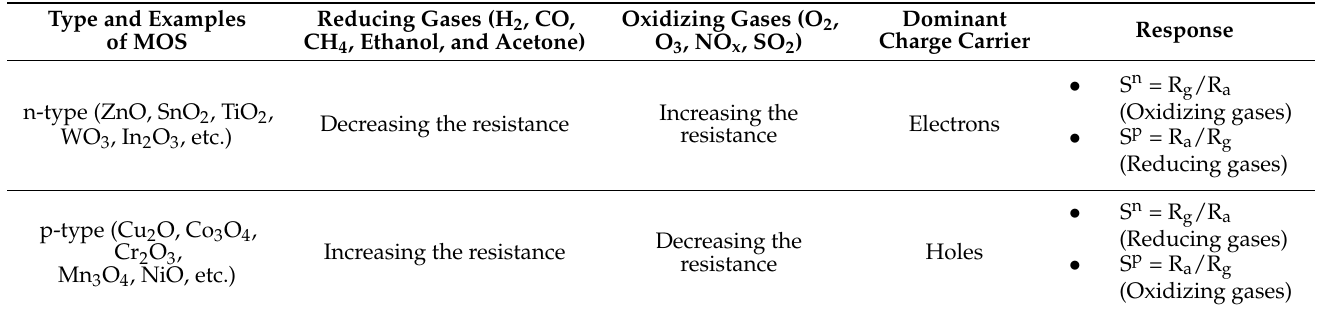
Table 3. The gas-sensing performance of n-type and p-type MOS towards reducing and oxidizing gases.